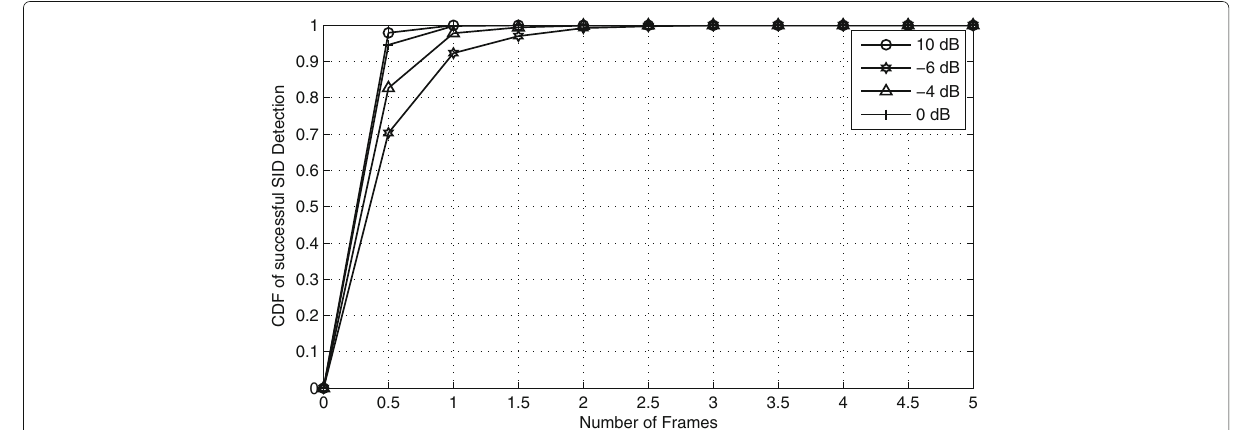
Fig. 7 CDF of the SID detection over number of frames